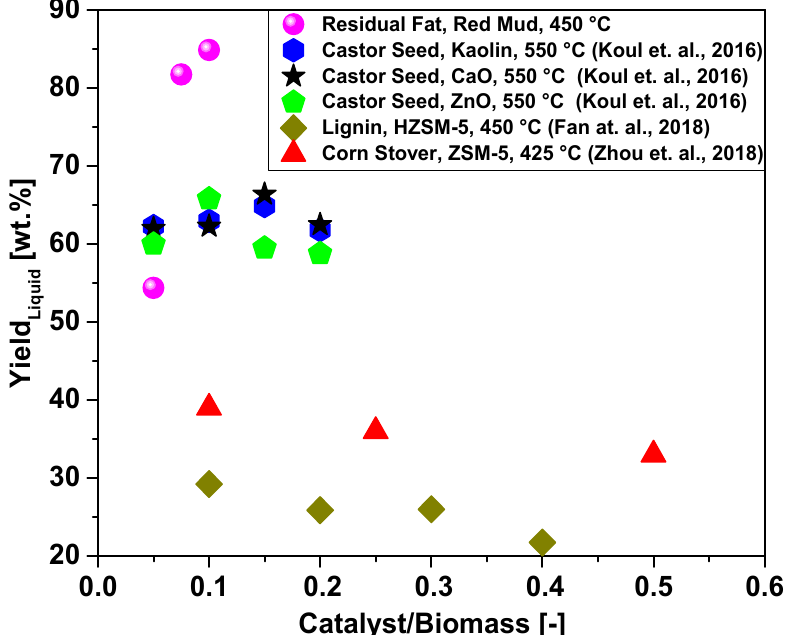
Figure 11. Effect of catalyst-to-biomass ratio within the range 0.0–0.5 on the yield of bio-oil obtained through the upgrading process, compared with similar studies in the literature [9,28,29].